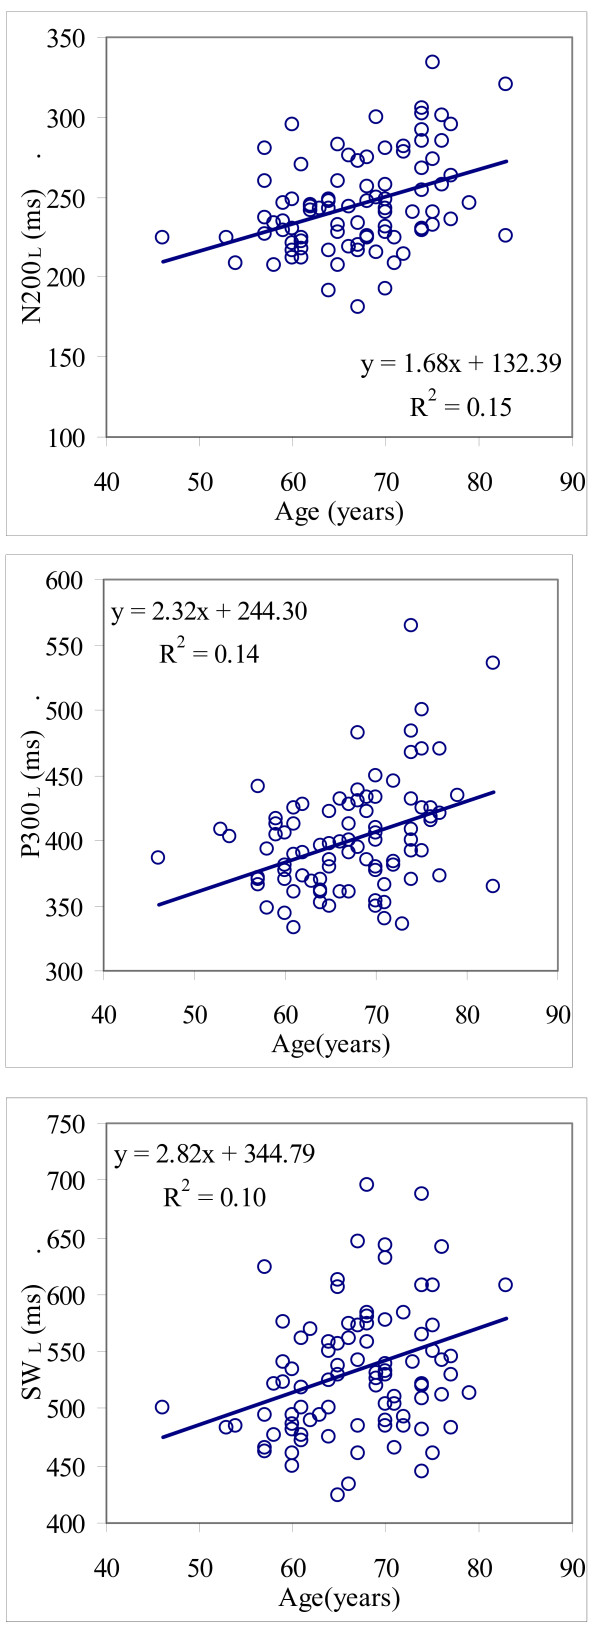
Scattergramms showing the relation between AERP latencies and age in MCI patients. From top to bottom: N200L-age, P300L-age and SWL-age.